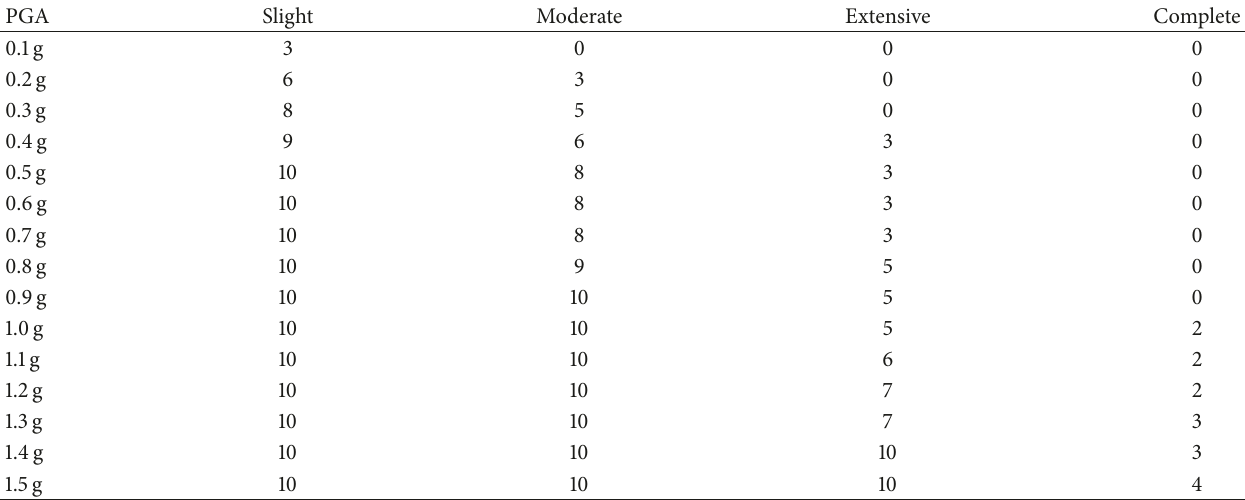
Table 4: Number of instances reaching or exceeding the limit states for the 5-story RC